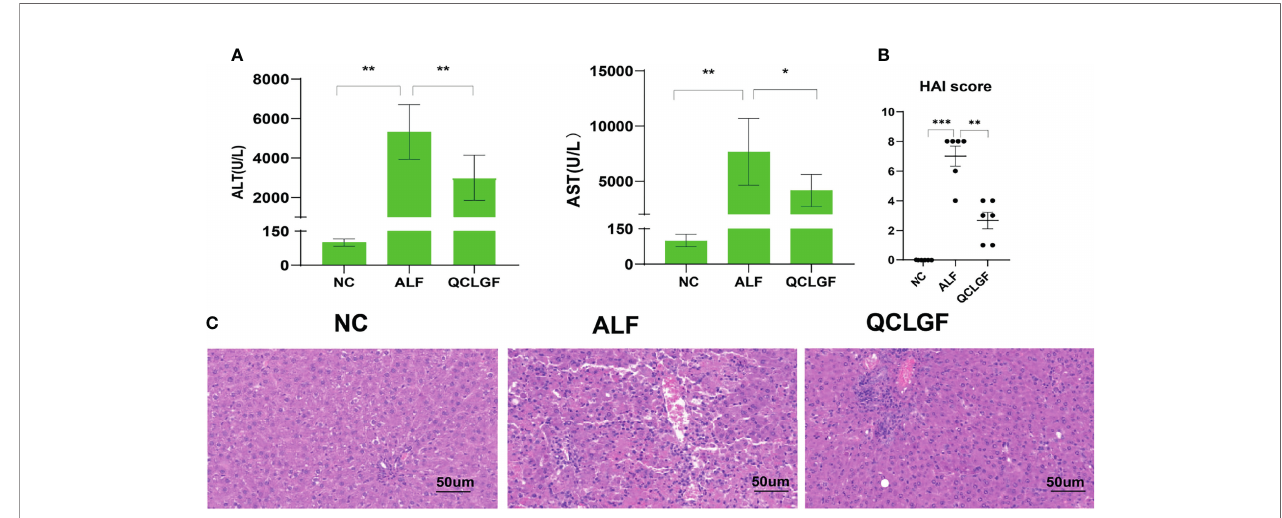
FIGURE 1 | QCLGF alleviates d-galactosamine-induced liver injury. (A) Plasma ALT and AST levels were determined 12 h after D-GalN intraperitoneal injection. (B) Liver HAI score. (C) Representative liver sections from different treated groups ( n = 6, per group). (* P < 0.05, ** P < 0.01 and *** P < 0.001 compared with the ALF group, Wilcoxon rank sum